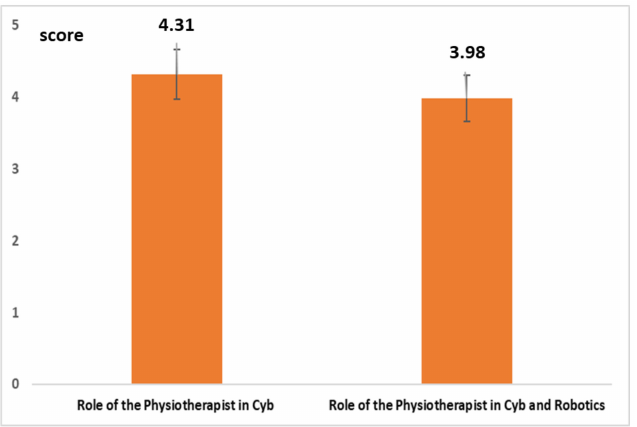
Figure 6. Level of training on the regulatory framework (also referred to robotics).